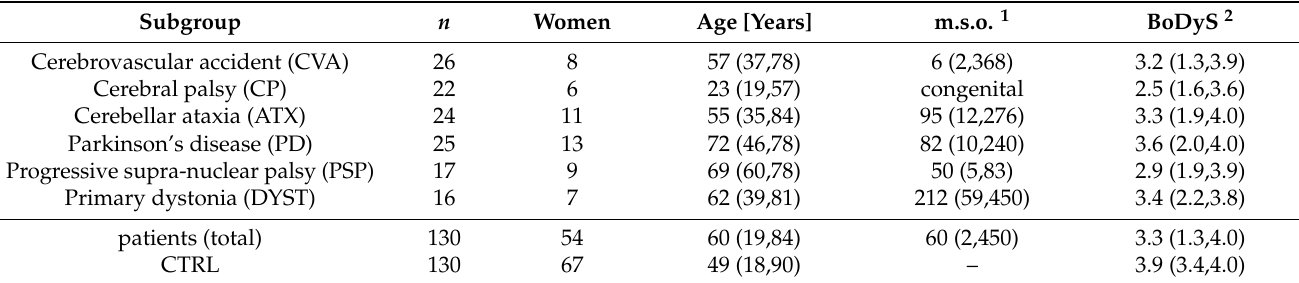
Table 1. Etiologic sub-samples of the patient